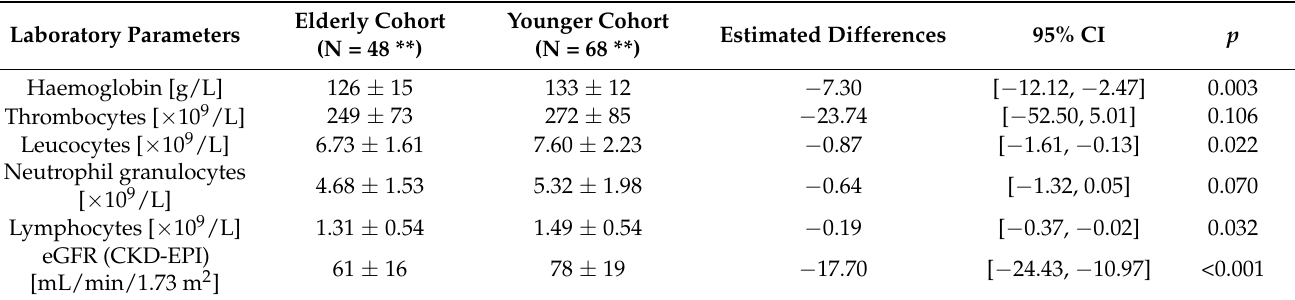
Table 3. Estimated mean differences of older vs. younger patients for the baseline values of laboratory parameters *, obtained by complete-case analyses, with confidence intervals and p -values for the difference of older vs. younger patients.